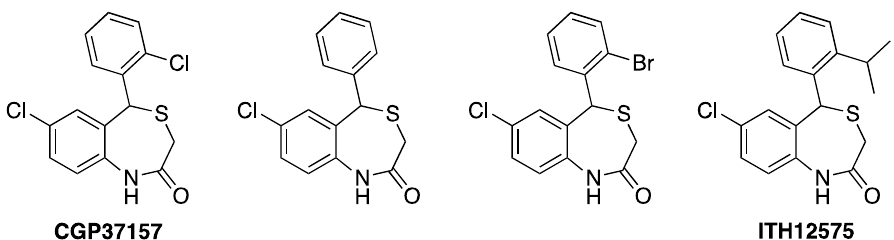
Figure 2. Chemical structures of CGP37157 and selected second generation analogues with NCLX blocking properties and neuroprotection